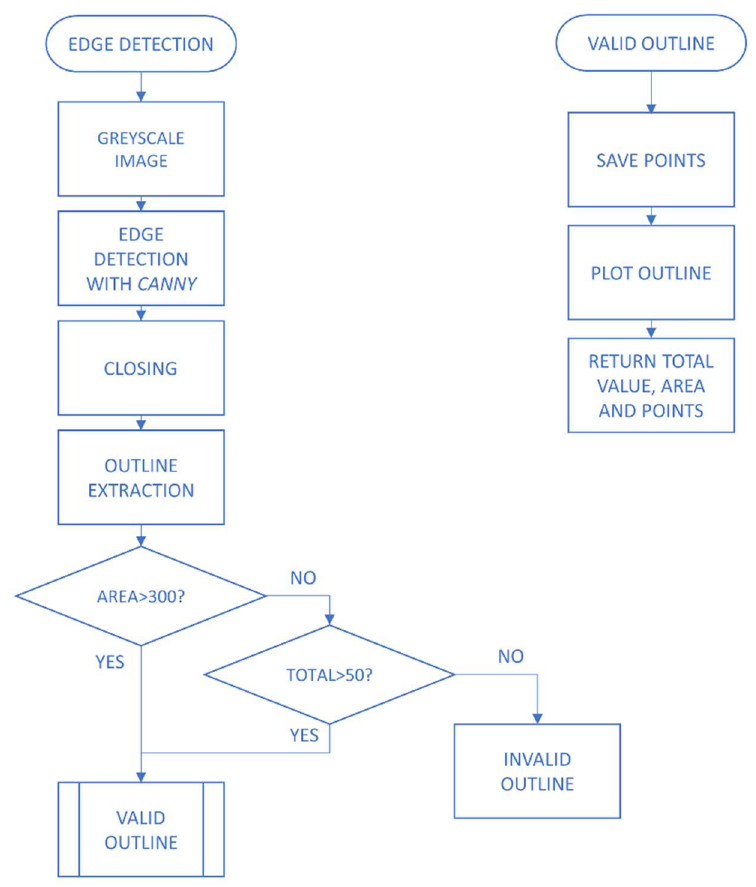
Figure 5. Routine and subroutine for edge detection.